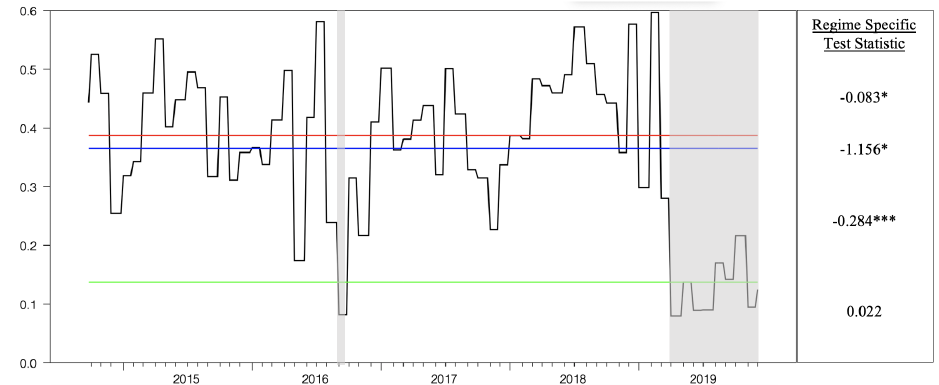
Figure 3. Threshold cointegration results with threshold variable overlay. Notes: Three thresholds (0.137, 0.365, and 0.387) were selected using the AIC from a maximum of three. The horizontal lines are the three endogenously determined thresholds. Test statistics for the null hypothesis of no cointegration for each regime are provided on the right hand side of the figure. The shaded areas indicate the time period for which the null hypothesis of no cointegration is rejected. Significance at α = 0.10, 0.05,0.01 denoted by *, **, and